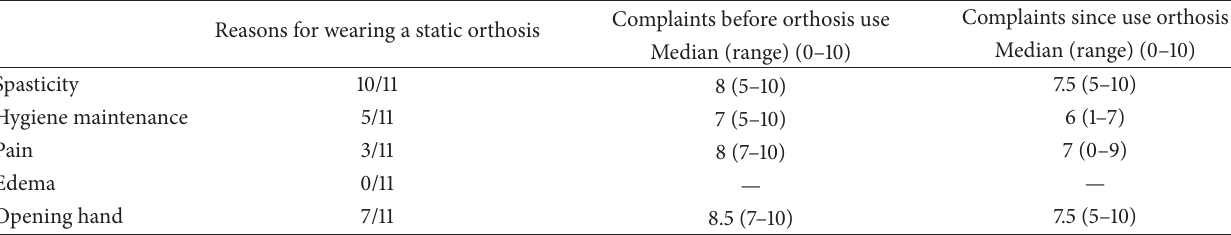
Table 2: Self-reported complaints in the hemiplegic upper